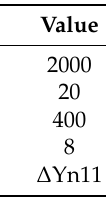
Table A4. Parameters of step-up